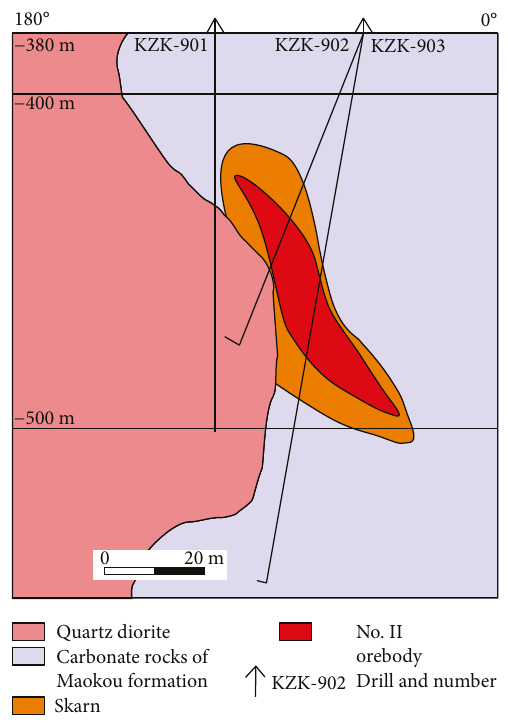
Figure 4: Pro fi le map of a drill hole showing part of the No. II orebody in the Fuzishan Cu-Mo deposit (modi fi ed after [37]).